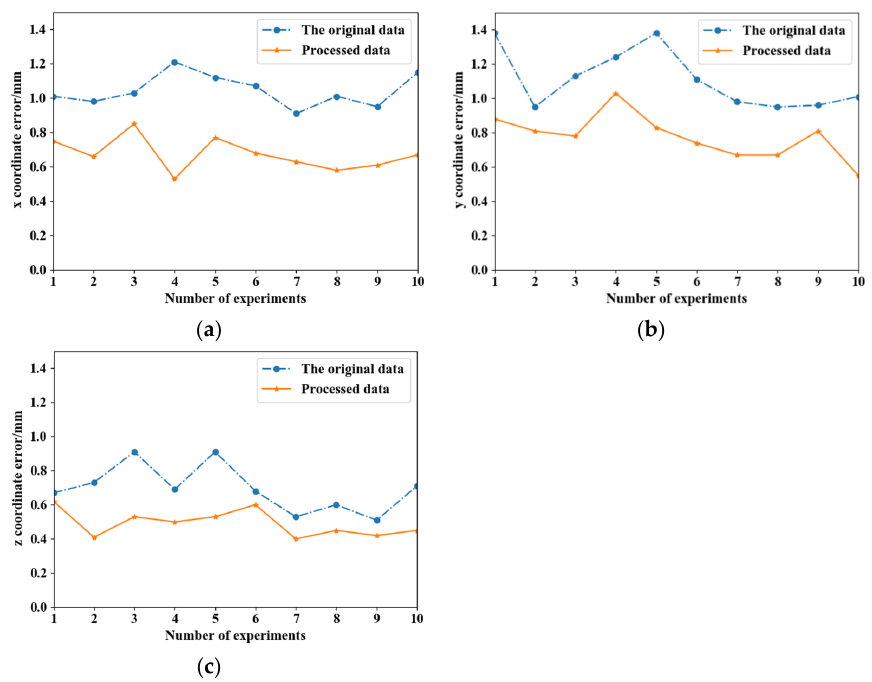
Figure 16. Hand–eye calibration error: ( a ) X coordinate hand–eye calibration error; ( b ) Y coordinate hand–eye calibration error; ( c ) Z coordinate hand–eye calibration error.